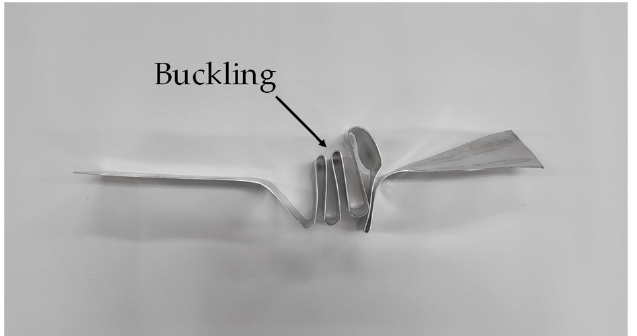
Figure 7. Gap between rollers.